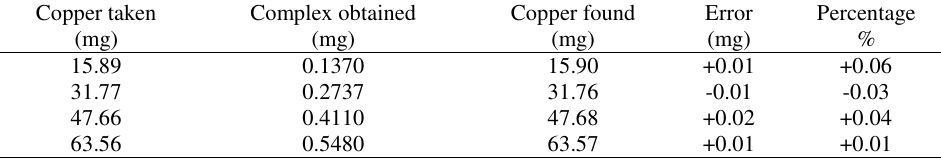
Table -1 . Result of gravimetric estimation copper (II) at pH 5; Cu(II)